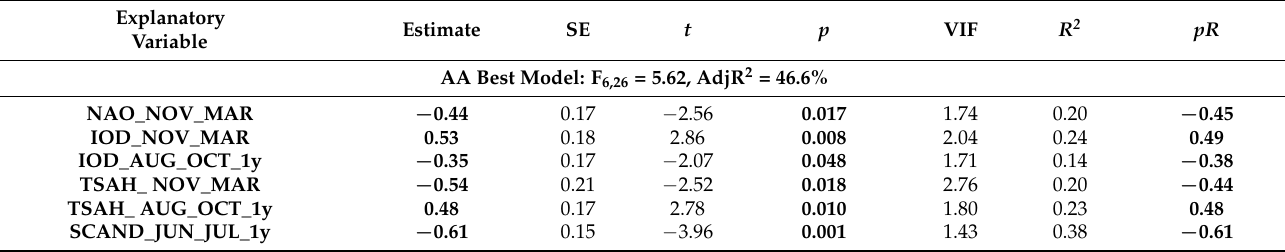
Table A18. Relationships between 15 climate variables and year and Annual Anomaly of the timing of spring migration for the Pied Flycatcher Ficedula hypoleuca caught at Bukowo, Poland, in 1982–2021. Symbols as in Tables 1 and A12. p < 0.05 marked in bold